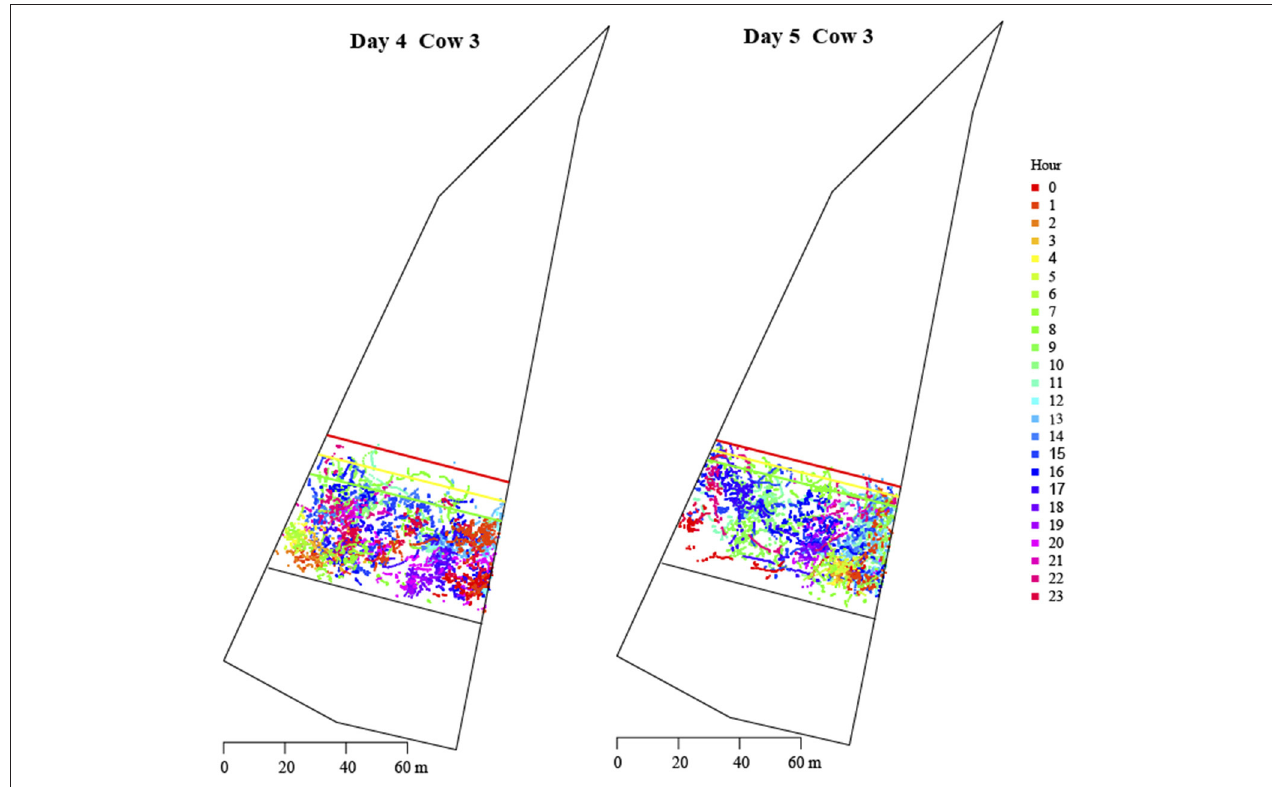
FIGURE 5 | Location of cow 3 by hour for Day 4 (left) and Day 5 (right). The zones are depicted with the colored lines. inclusion zone; buffer zone; exclusion zone; physical